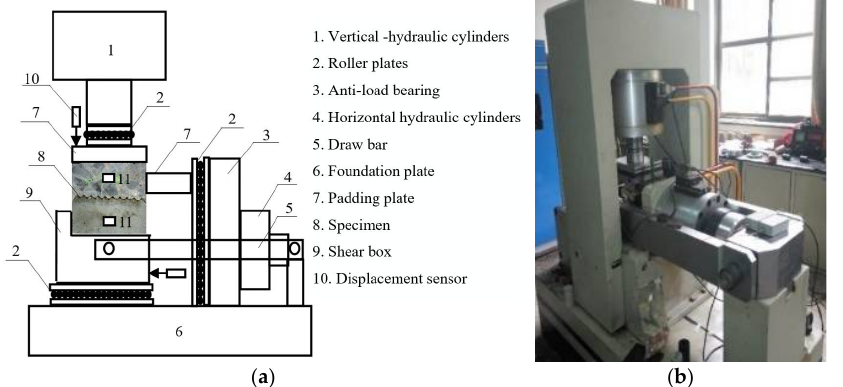
Figure 10. The RMT-150B system used in this experimental test: ( a ) test equipment schematic; ( b ) physical test equipment. ( b ) physical test